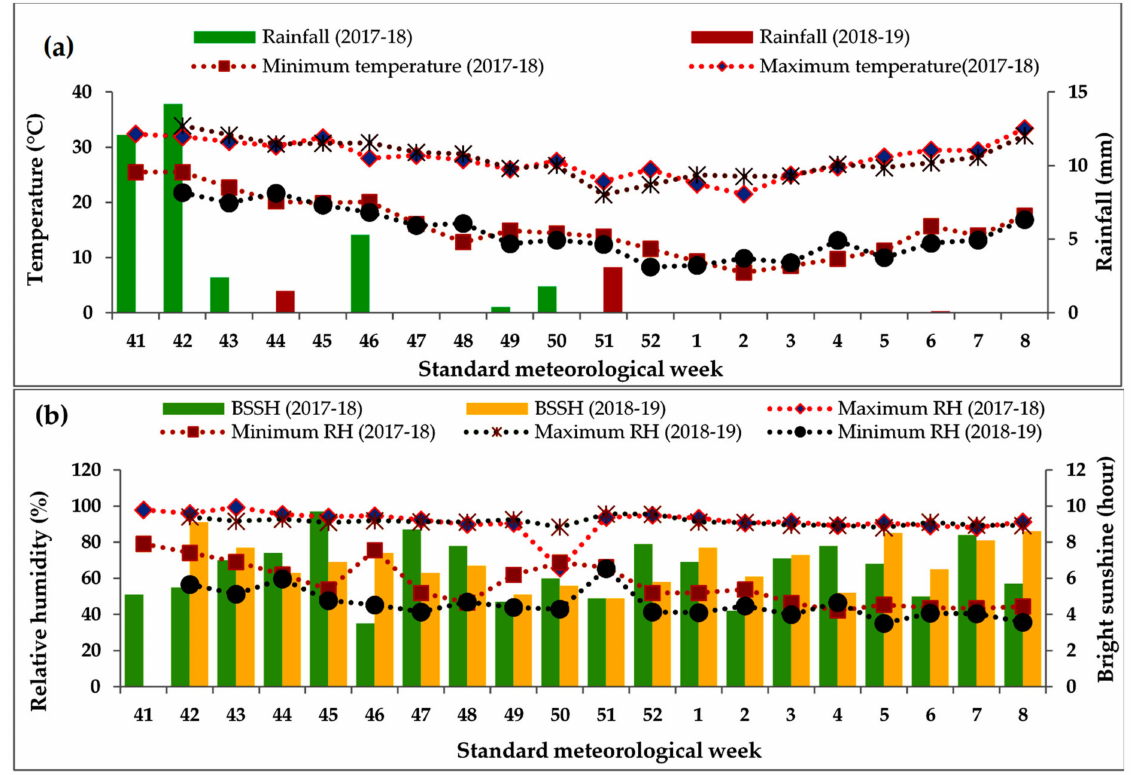
Figure 1. Meteorological features ( a ) rainfall and temperature; ( b ) relative humidity (RH) and bright sunshine hours (BSSH)) of the experimental site during 2017–2018 and 2018–2019.